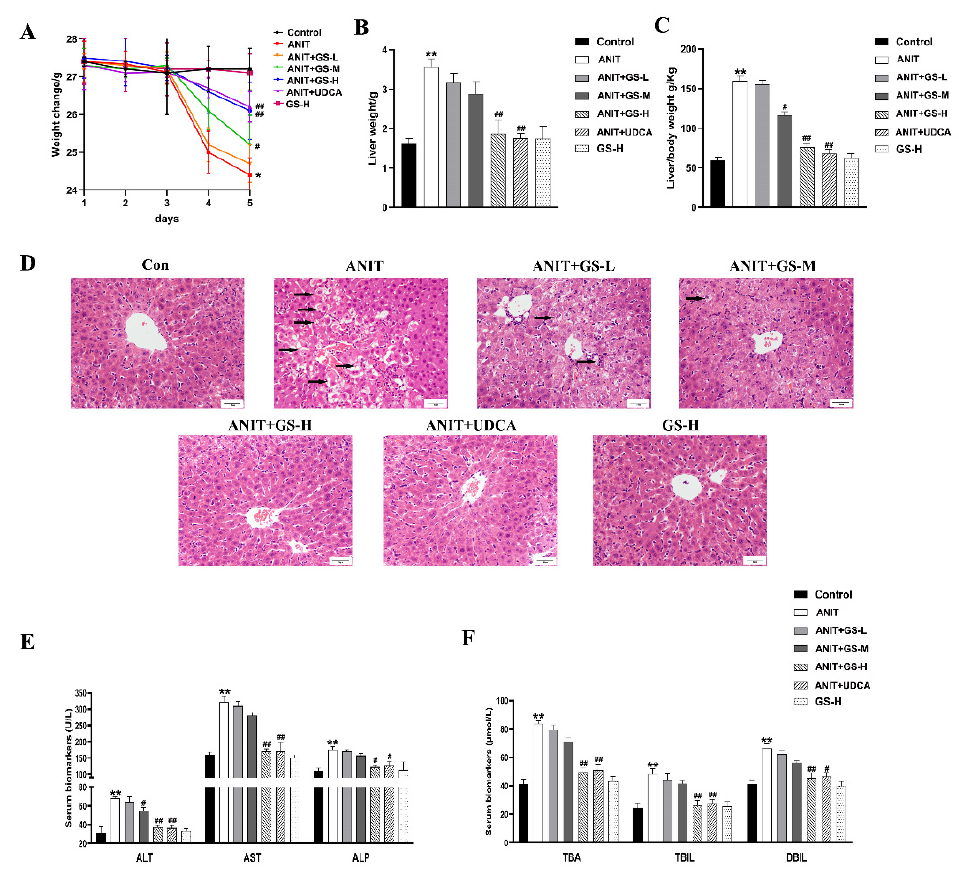
Figure 2. GS markedly improved cholestatic liver injury in ANIT-induced mice. ( A ) Body weight changes of mice from day 1–5. ( B ) Comparison of liver weight in each group on the fifth day. ( C ) Comparison of liver weight/body weight ratio in each group on the fifth day. ( D ) Histopathology in hematoxylin and eosin-stained liver sections (Scale bar, 50 um). Black arrows, histological damage. ( E , F ) The levels of ALT, AST, ALP, TBA, TBIL, and DBIL in serum of mice. Significantly different from control, ** p < 0.01, or ANIT, # p < 0.05 or ## p < 0.01.